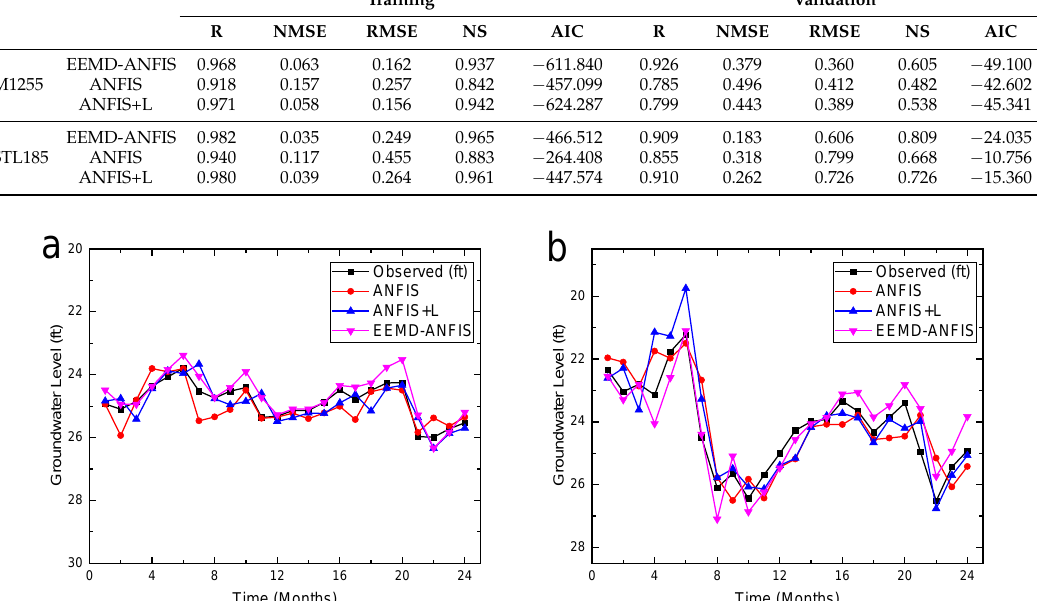
Table 3. Result of modeling from the ANFIS model at site M1255 and STL185.